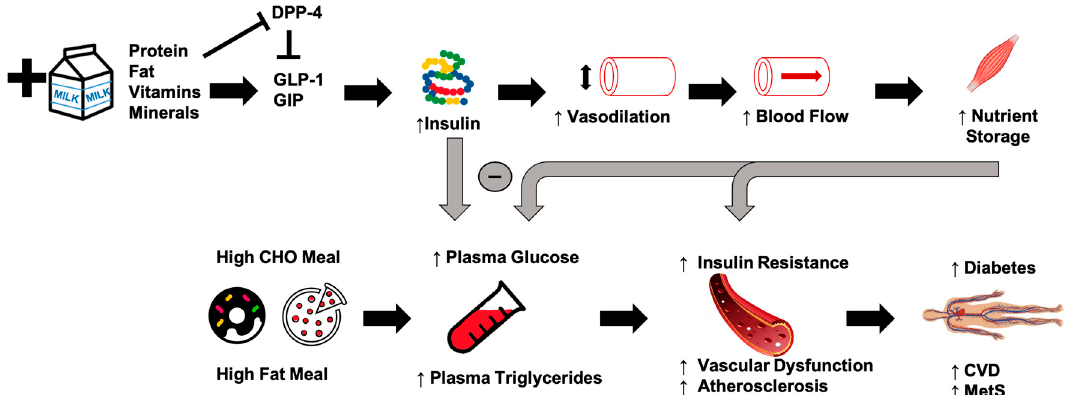
Figure 1. The addition of milk and dairy products to a meal high in carbohydrates or fat may potentially lessen the risk of cardiometabolic diseases through reductions in postprandial reductions in blood glucose and triglycerides. Purported mechanisms include dairy proteins and bioactive compounds acting via vascular function. CHO = carbohydrate, CVD = cardiovascular disease, MetS = metabolic syndrome, GIP = glucose-dependent insulinotropic polypeptide, GLP-1 = glucagon-like- peptide-1, DPP-4 = dipeptidyl peptidase